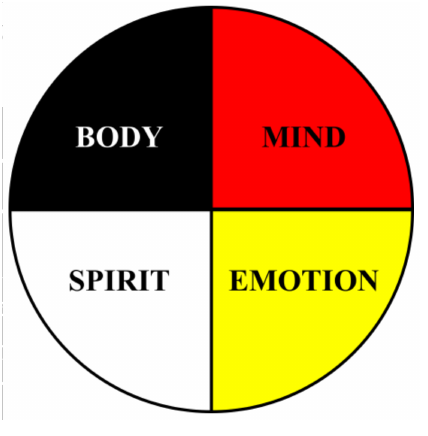
Figure 2. Medicine Wheel.